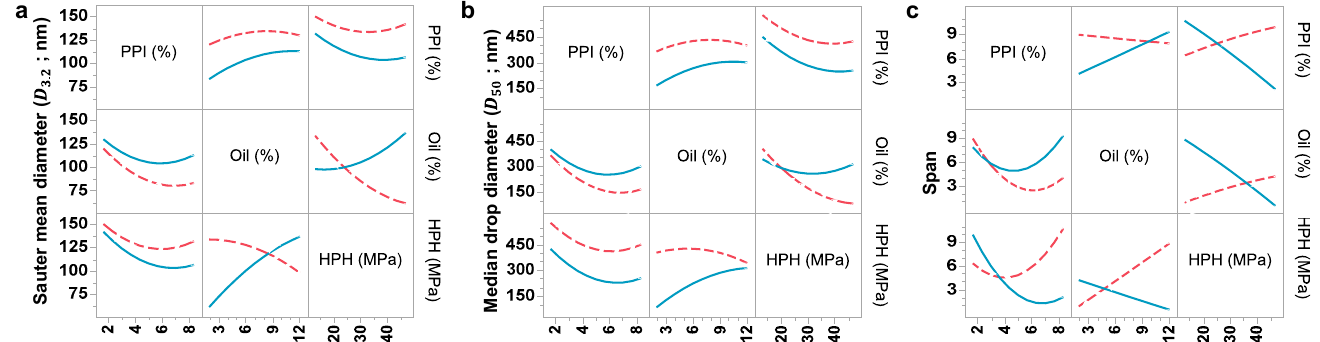
Figure 2. Interaction profiler chart for the response surface evaluation of the emulsion characteristics: